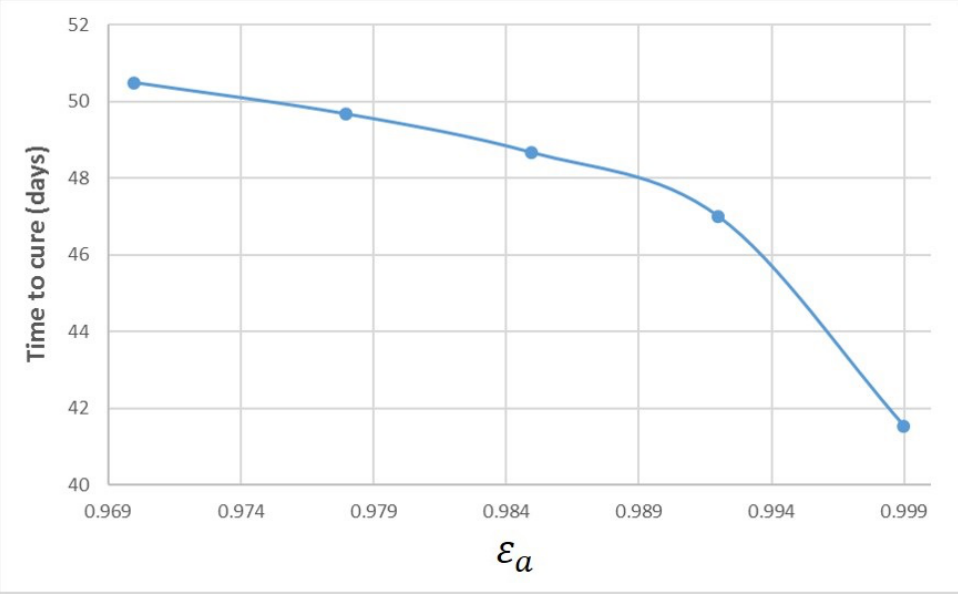
Figure A4. Influence of parameter (cid:101) a in the multiscale model on